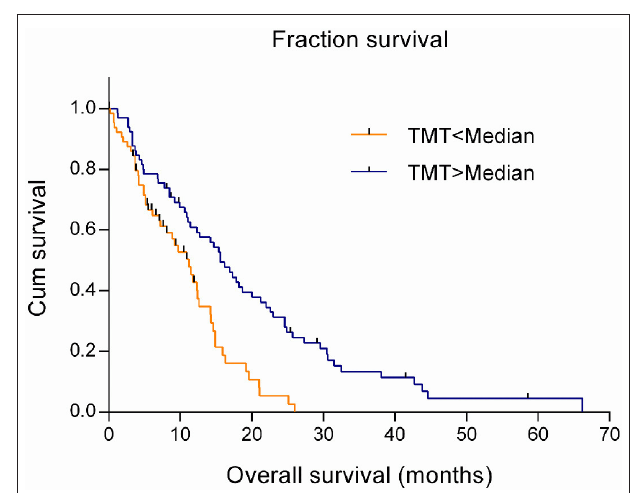
FIGURE 2 | Overall survival according to median TMT of 130 primary GBM